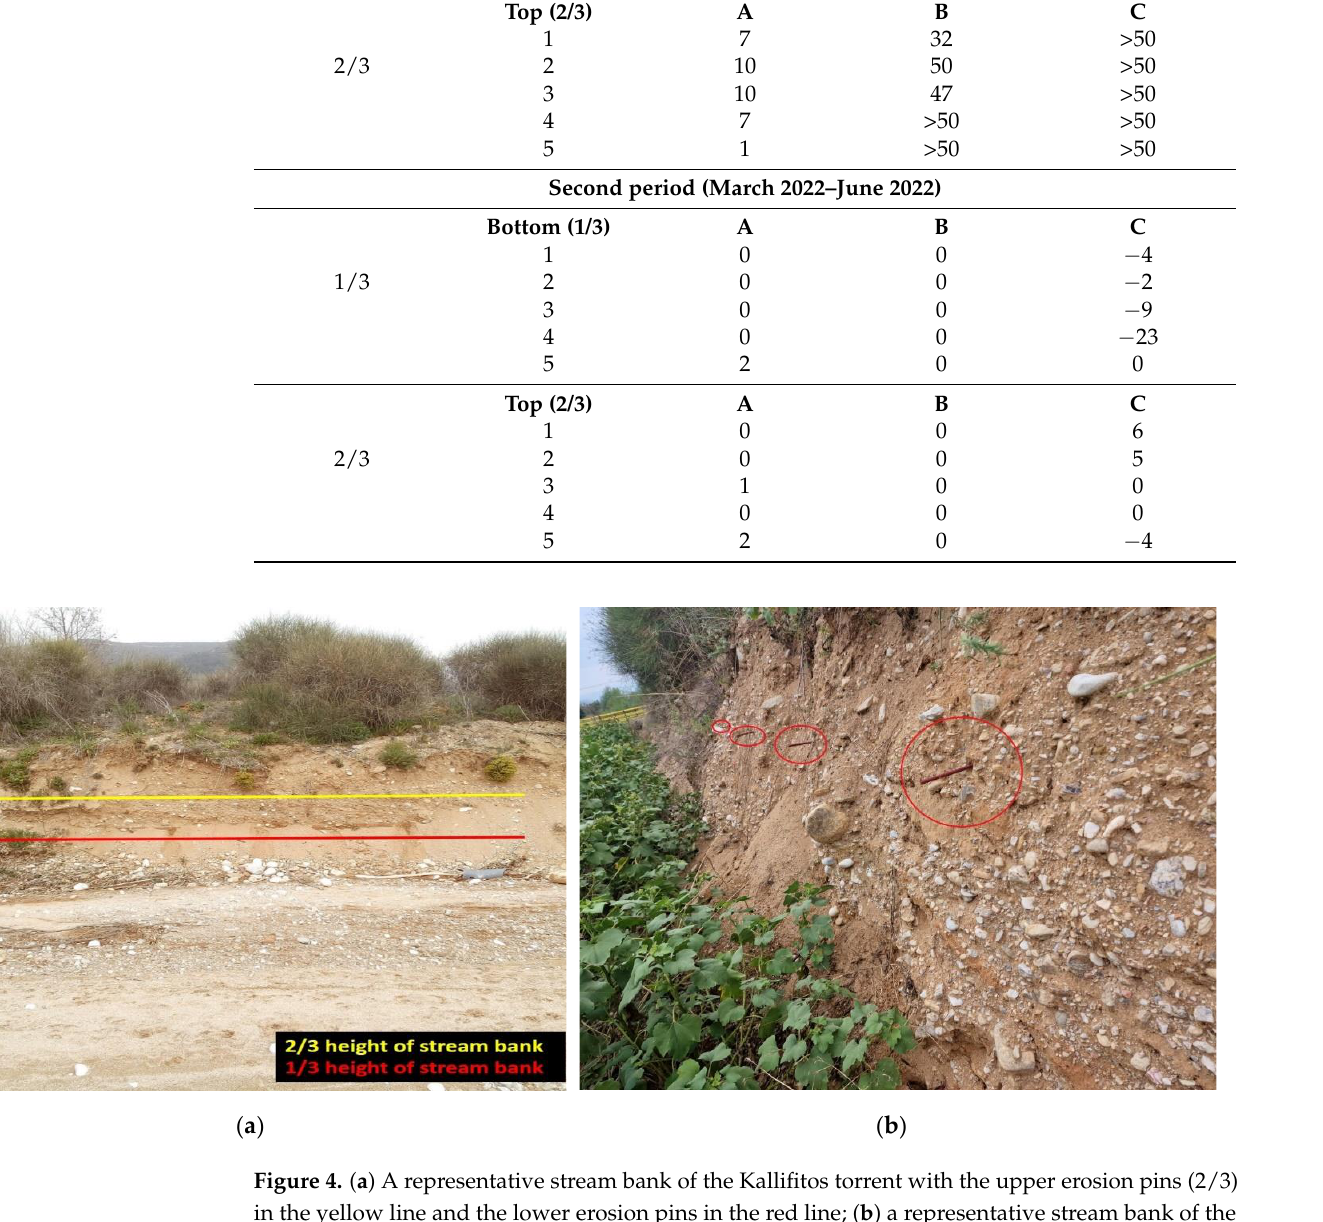
Figure 4. ( a ) A representative stream bank of the Kallifitos torrent with the upper erosion pins (2/3) in the yellow line and the lower erosion pins in the red line; ( b ) a representative stream bank of the Kallifitos torrent with erosion pins (red circles) installed at the upper part (2/3) while the lower part (1/3) was covered by soil